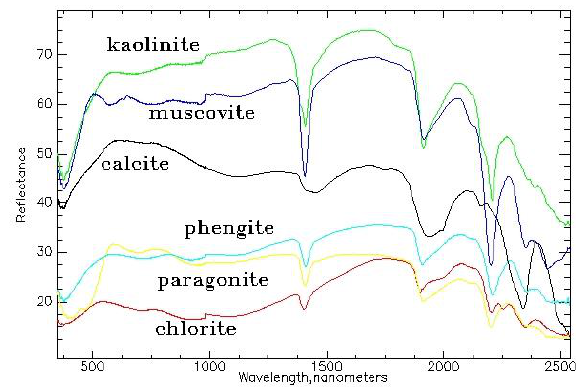
Figure 5. Field rock spectra measured by SVC spectrometer